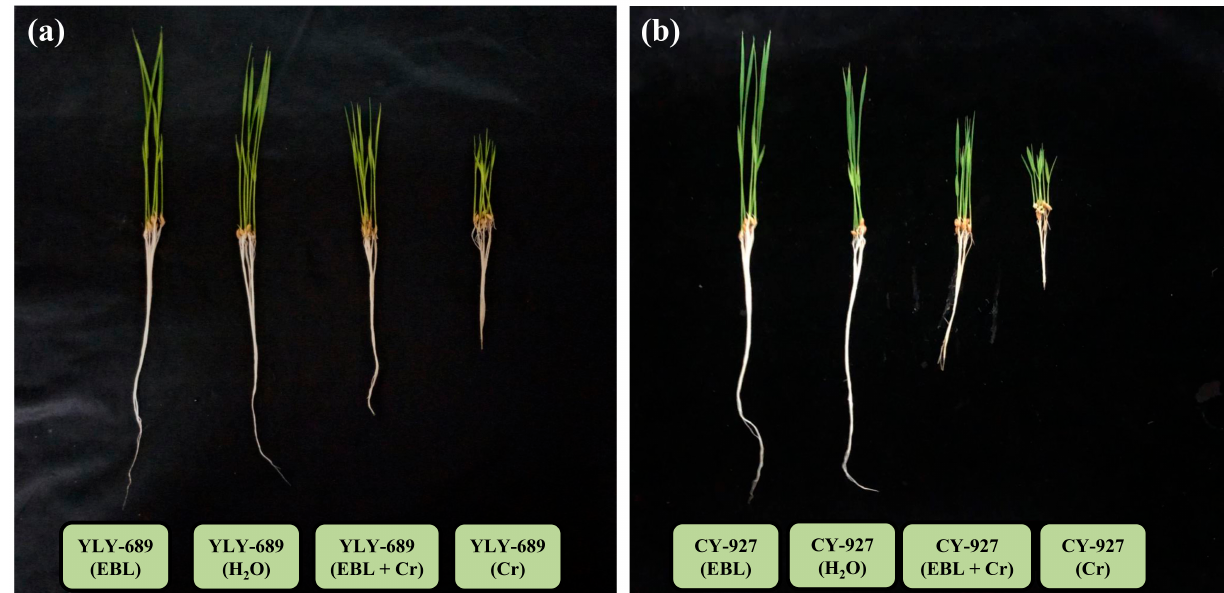
Figure 1. Physiological effect of Cr toxicity on two different rice cultivars. ( a ) Physiological effect of Cr on the YLY-689 cultivar and stress alleviation effect of 0.01 µM EBL under 100 µM Cr concentration. ( b ) Physiological effect of Cr on cultivar CY-927 and stress alleviation effect of 0.01 µM EBL under 100 µM Cr concentration.